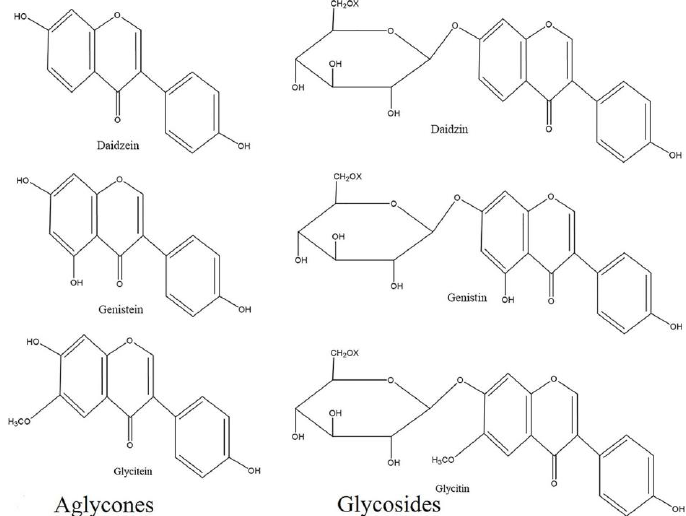
Figure 1. Chemical structure of soybean isoflavones. In soybeans, isoflavones are present in two isoforms: aglycones and glycosides. Release of the sugar moiety from glycosides often generates aglycones. Glycosides have three chemical isoforms: β -glucoside, acetylglucoside, and malonyl glucoside (X represents H, COCH 3 , and COCH 2 COOH in β -glucoside, acetylglucoside and malonylglucoside, respectively). Chemical structures were drawn using ChemDraw Standard 13.0 software (PerkinElmer, Waltham, MA,